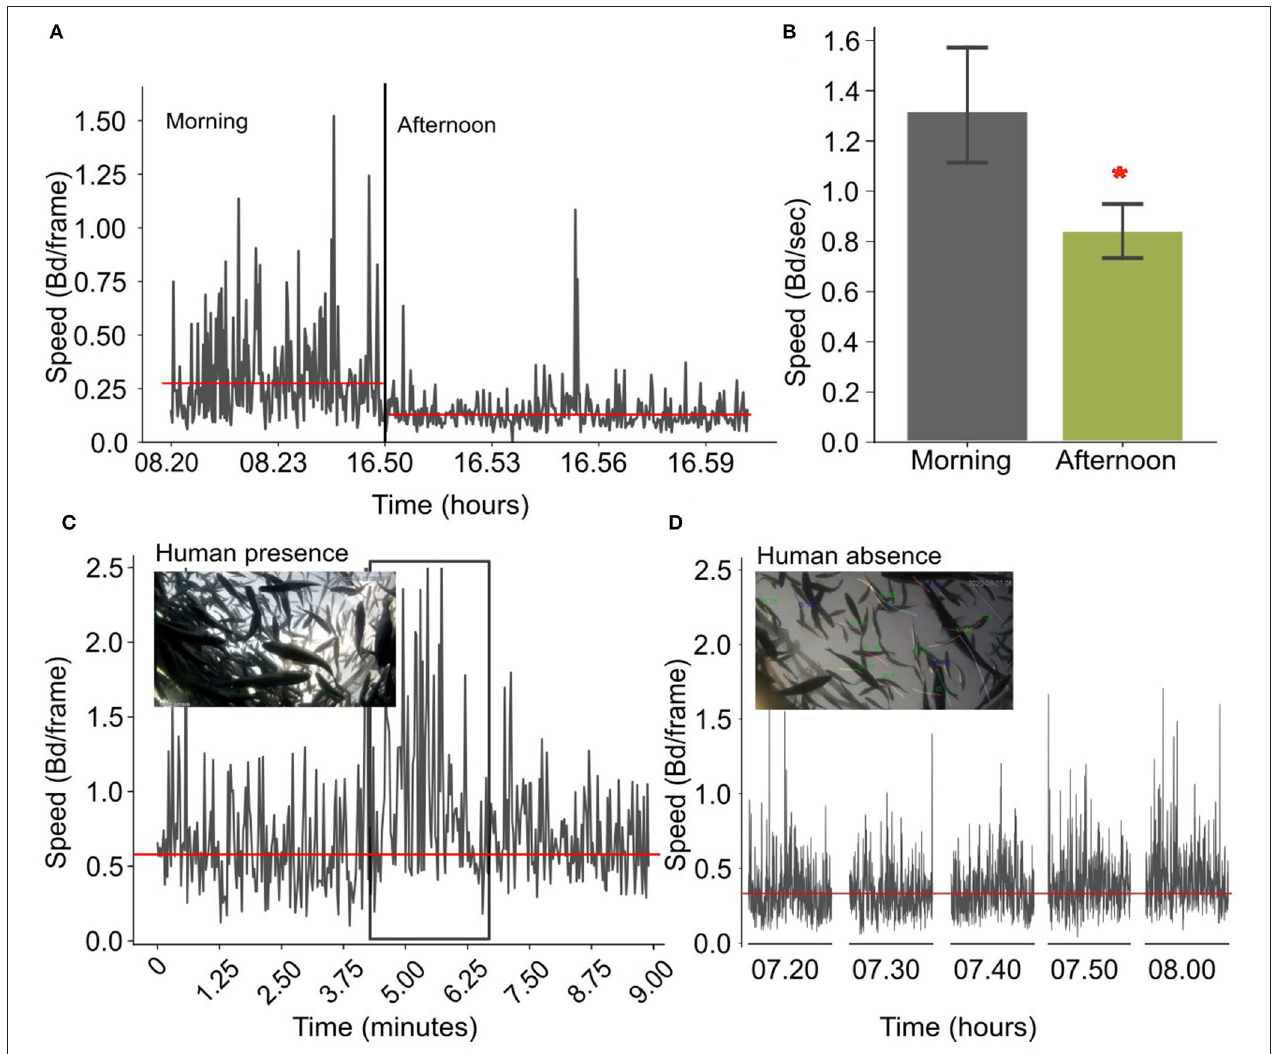
FIGURE 9 | (A) Time-series showing the variation of the normalized speed in the morning and in the afternoon for one example day. The reference line is the average speed in the morning and in the afternoon. (B) Bar plots showing the variation of the normalized speed (bd/frame) for the morning and the afternoon averaged over 30 days (the asterisk shows a statistical significance); (C) Instantaneous speed changes when there is a human presence in the cages. (D) Speed variations when there is no human presence in the cages. Horizontal lines indicate the average instantaneous